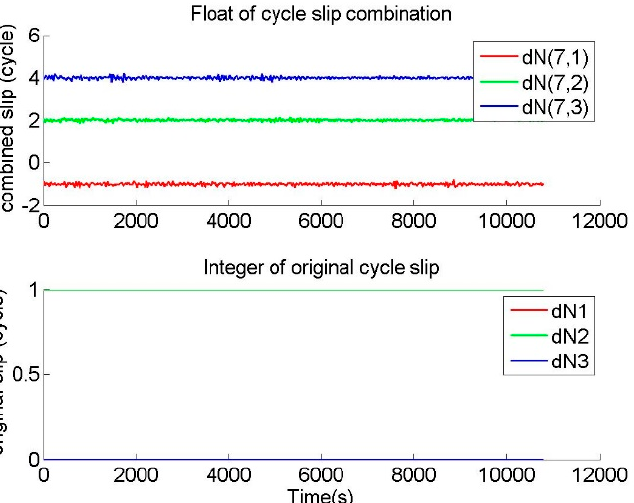
Figure 9. Repair results of the cycle slip combinations and original cycle slips from GTCSR, where the phase data had the known cycle slips of (1,1,0) epoch by epoch on GPS satellite 10 at CUT0 station during the geomagnetic storm that started from UTC 2016/05/08 00:00:00.